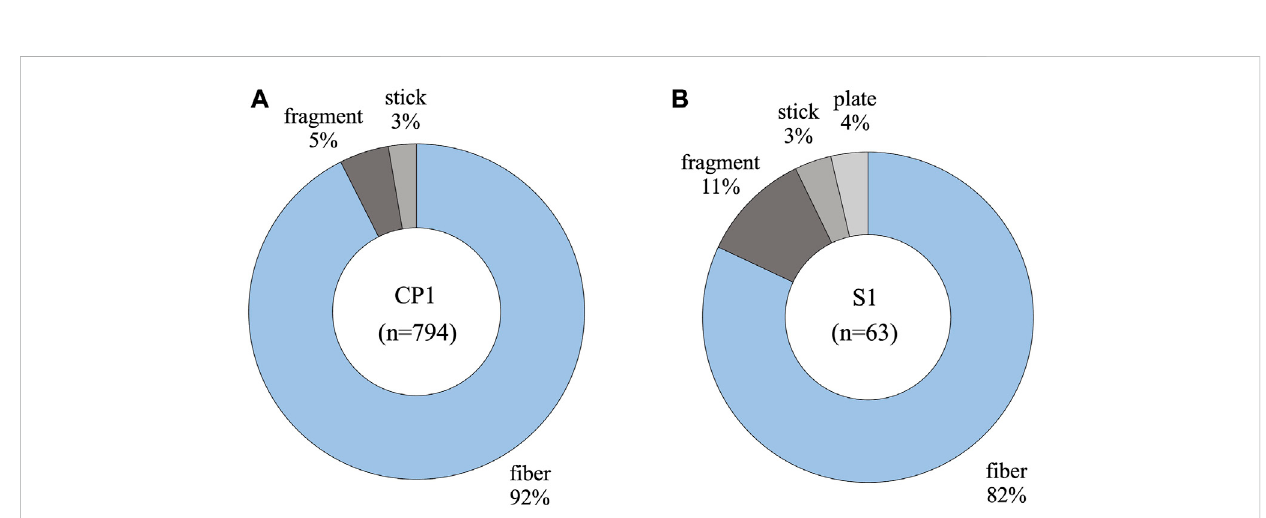
FIGURE 5 Shapes of microplastics in the sediment cores. Percentage proportions of shape categories of microplastics in (A) the CP1 sample and (B) the S1 sample.